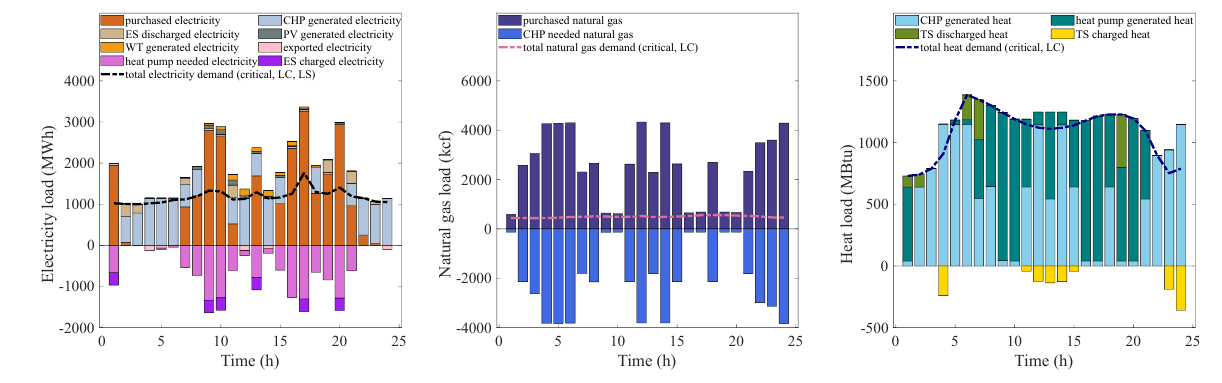
Figure 8. Operational results of microgrid 3. Table 7. Profit of retailer with different scenarios. Scenario 1 Scenario 2 Scenario 3